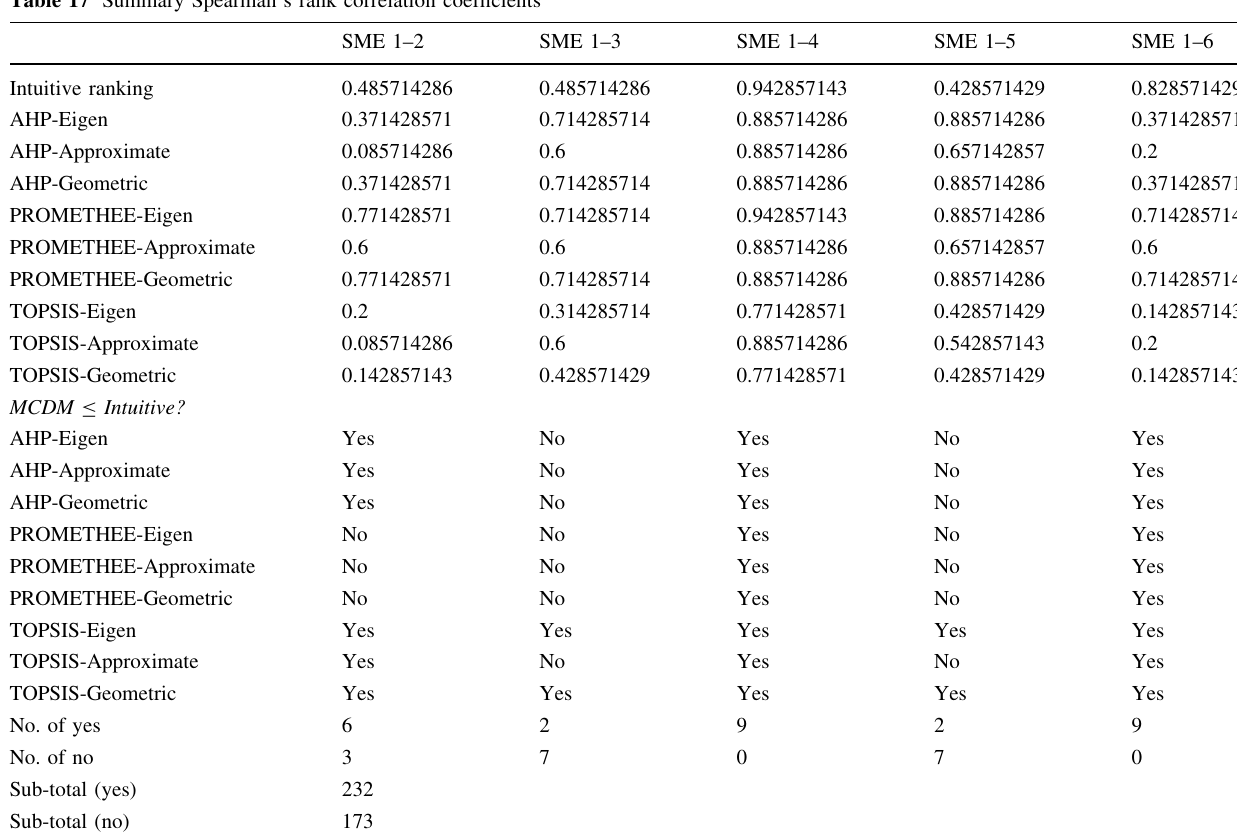
Table 17 Summary Spearman’s rank correlation